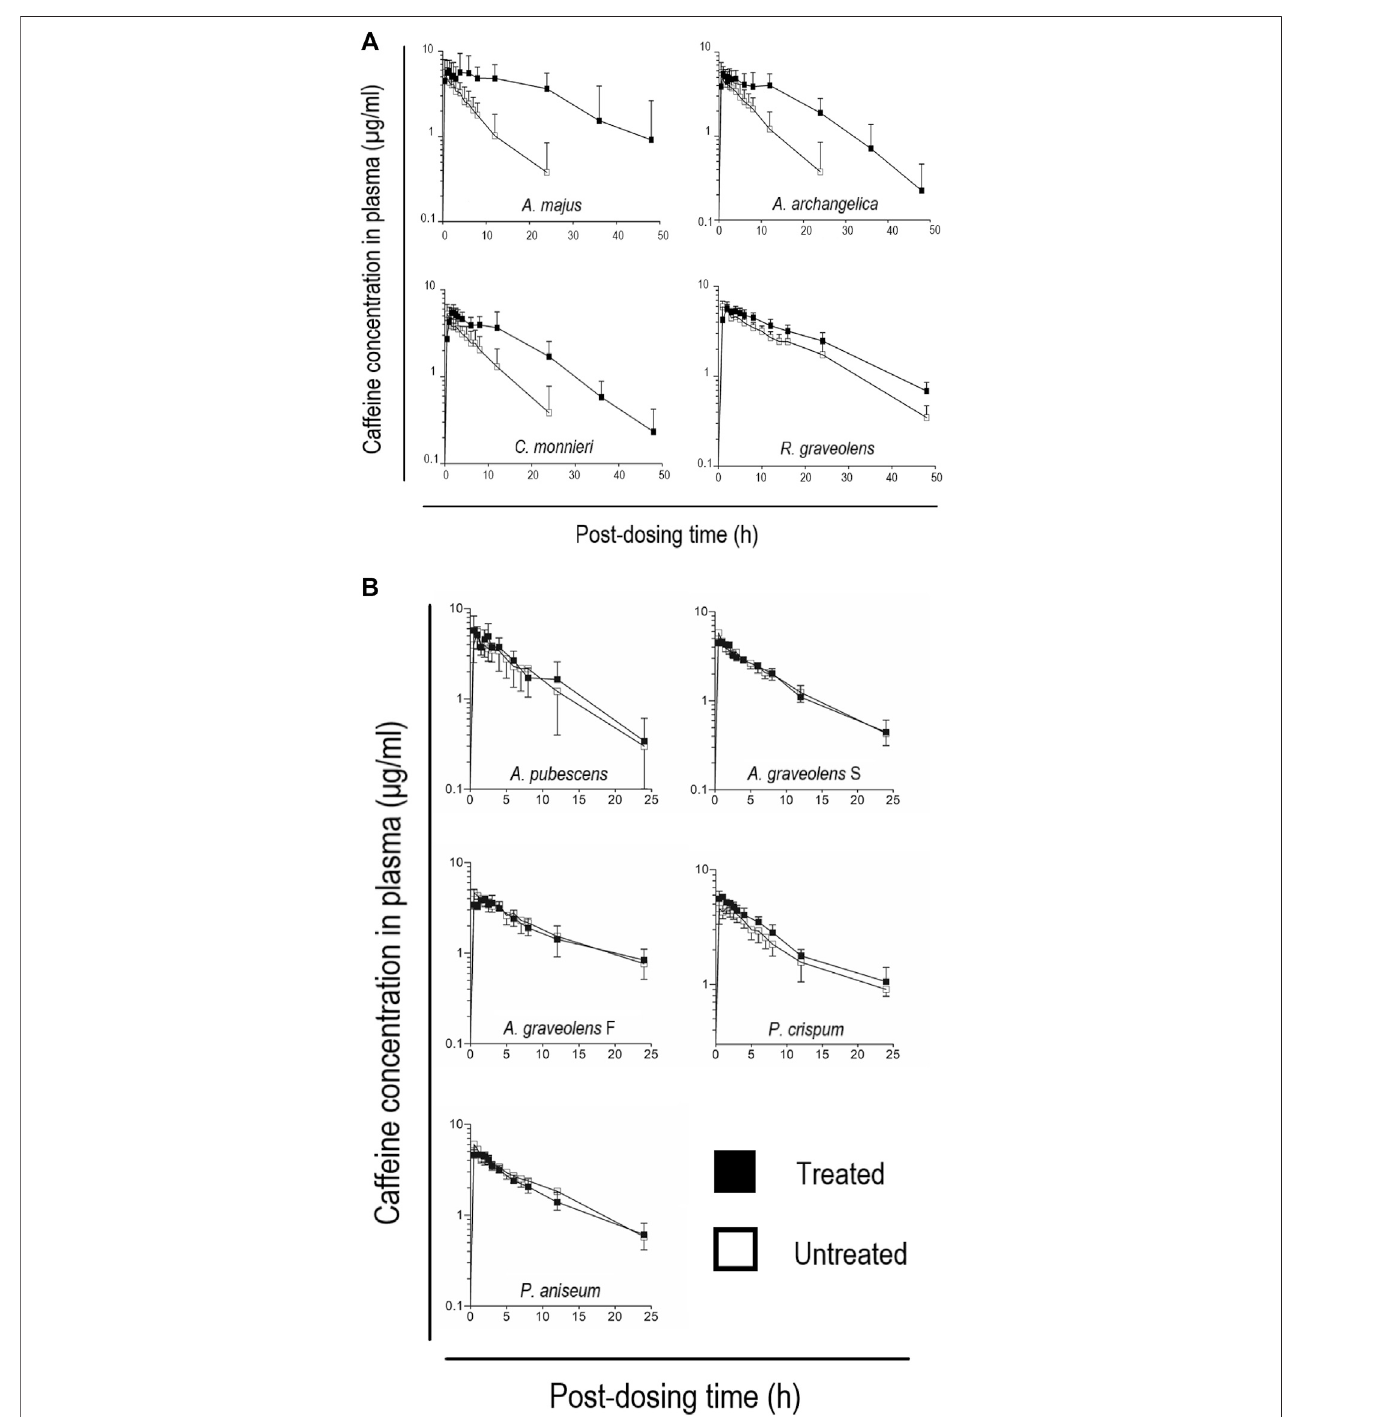
FIGURE 3 | (A) Time course of caffeine concentration in the plasma of volunteers before and after pre-treatment with an extract of A. majus, A. archangelica, C. monnieri, and R. graveolens . Each point is plotted as mean ± SD. Empty squares represent caffeine concentrations in volunteers with no ARFP extract pre-treatment. Filled squares represent caffeine concentrations in volunteers with ARFP extract pre-treatment 3.0 h before receiving the caffeine tablets. (B) Time course of caffeine concentrations in the plasma of volunteers before and after pre-treatment with an extract of P. aniseum, P. crispum, A. pubescens, A. graveolens seeds , and A. graveolens fl akes.Thepointisreportedasmean ± SD.EmptysquaresrepresentcaffeineconcentrationsinvolunteerswithnoARFPextractpre-treatment.Filledsquares represent caffeine concentrations in volunteers with ARFP extract pre-treatment 3.0 h before receiving the caffeine tablets.